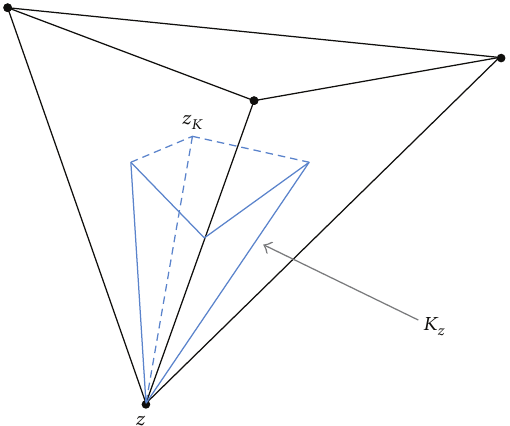
Figure 4: 𝑞 𝑒 is the midpoint of the edge 𝑒 , and 𝑞 𝑆 of the face 𝑆 𝑖